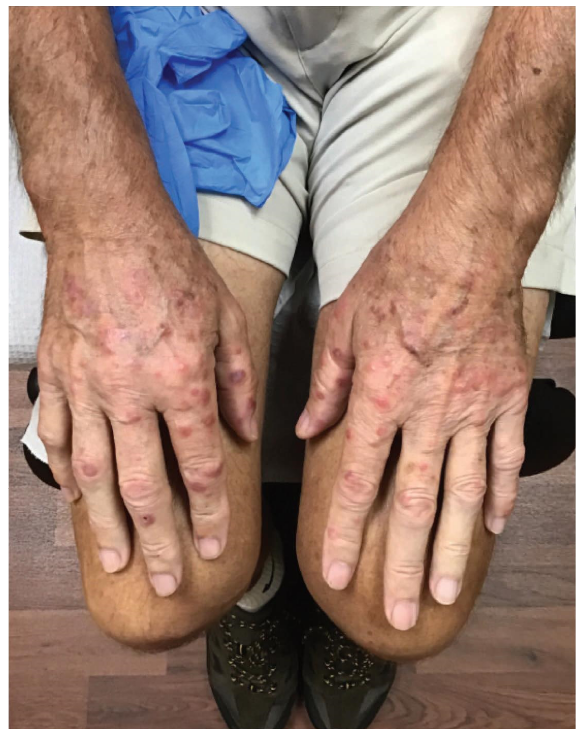
Figure 1: Patient presentation at rash onset.